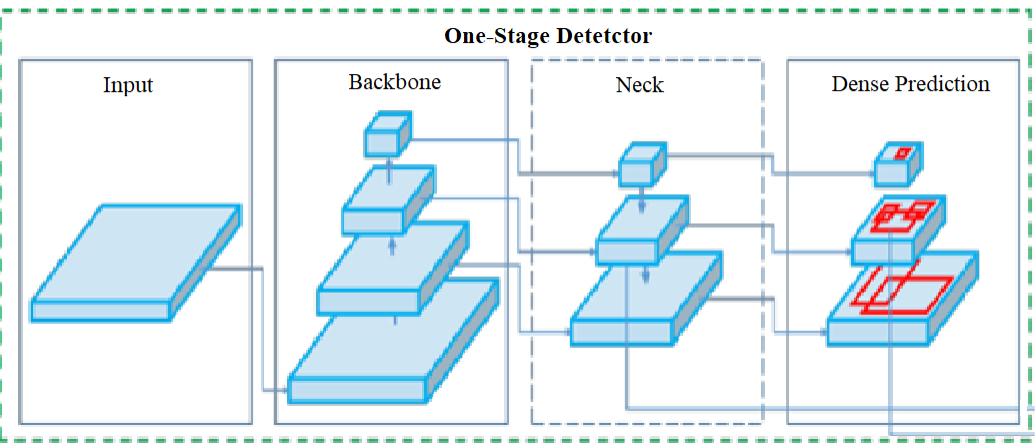
Figure 4. YOLOv4 architecture [34].